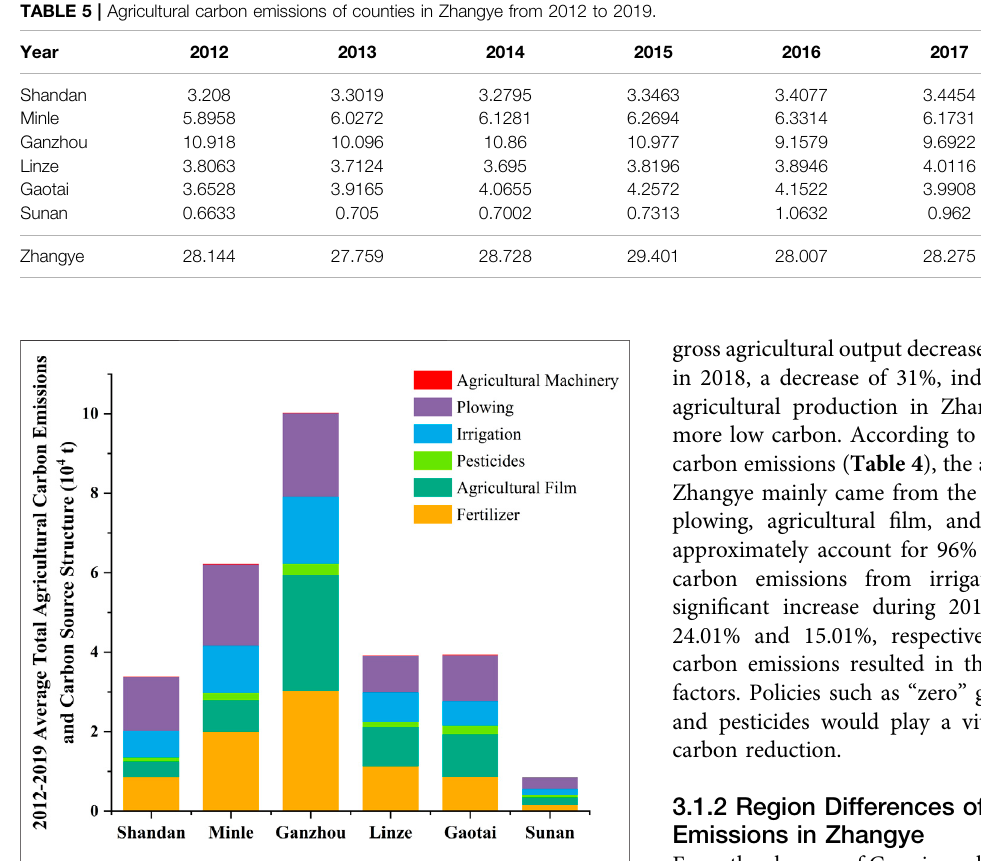
FIGURE 4 | Total and structure of agricultural carbon emissions in counties and districts of Zhangye.